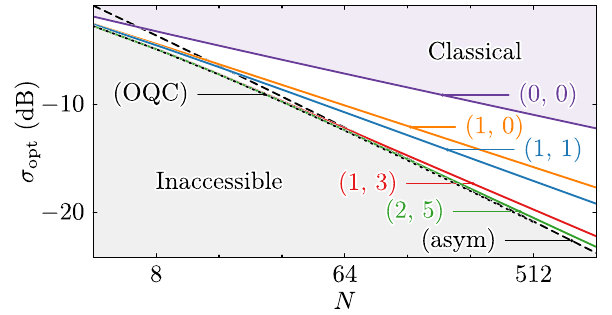
FIG. 11. Particle number N dependence of the dimensionless Allan deviation of a flicker-frequency-noise-limited clock at a constant averaging time τ and the optimal Ramsey interrogation time for different circuit complexities ð n variational parameters. For comparison we also show the per- formance of the optimal quantum clock (dotted line) and the asymptotic behavior [see Eq. (28)] obtained from the π -corrected HL (dashed